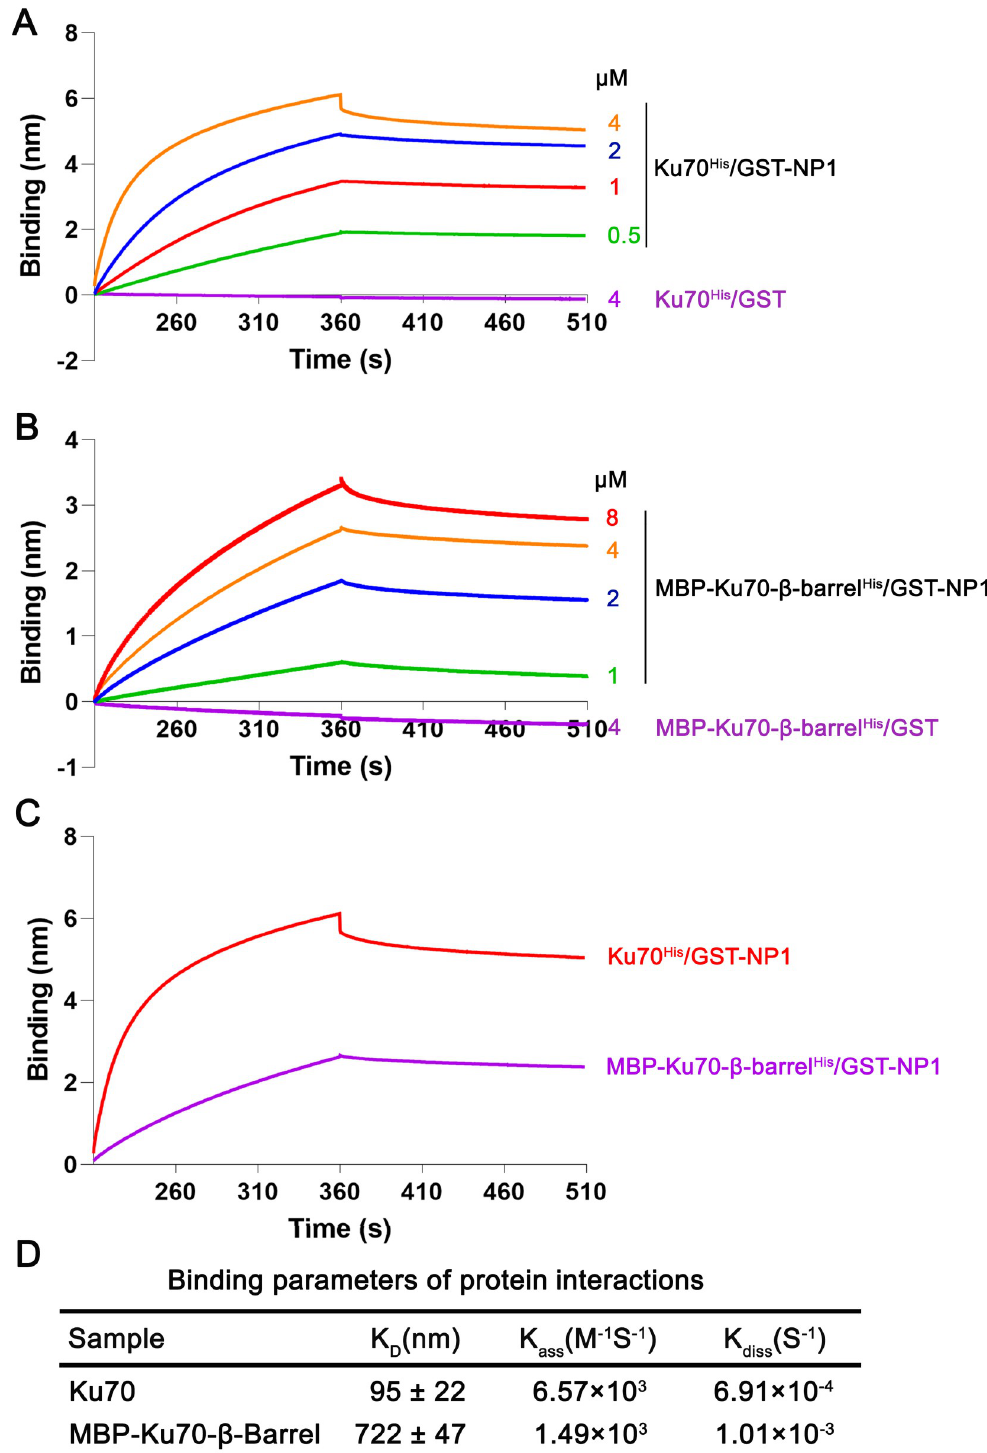
Fig 5. BLI analysis of the interaction kinetics between Ku70 and MBP-Ku70- β -barrel His with HBoV1 NP1. (A-B) Kinetic assays using Ni-NTA biosensors. The binding kinetics of associations and dissociations of 4 μ M GST-NP1 with (A) Ku70 His and (B) MBP-Ku70- β -barrel His at different indicated concentrations. Binding kinetics of 4 μ M GST with 4 μ M Ku70 His or MBP-MBP-Ku70- β -barrel His is shown as controls. (C) Comparison of the binding affinities of NP1 to Ku70 and to Ku70- β -barrel. The binding kinetics of association and dissociation of Ku70 His (4 μ M) and MBP-Ku70- β -barrel His